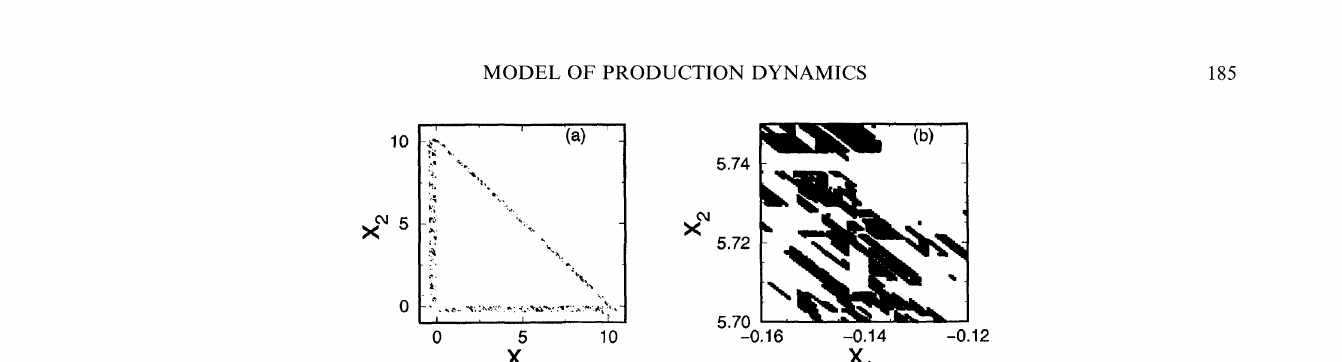
FIGURE 8 The structure of the phase space of the mapping (4). In (a) only points outside the triangle (i.e., the points where switchings occur) are shown. The attractor is built by 10000 points of one trajectory (with transients discarded). A small part of (a) is enlarged in (b); here one can see that the attractor consists of open domains.